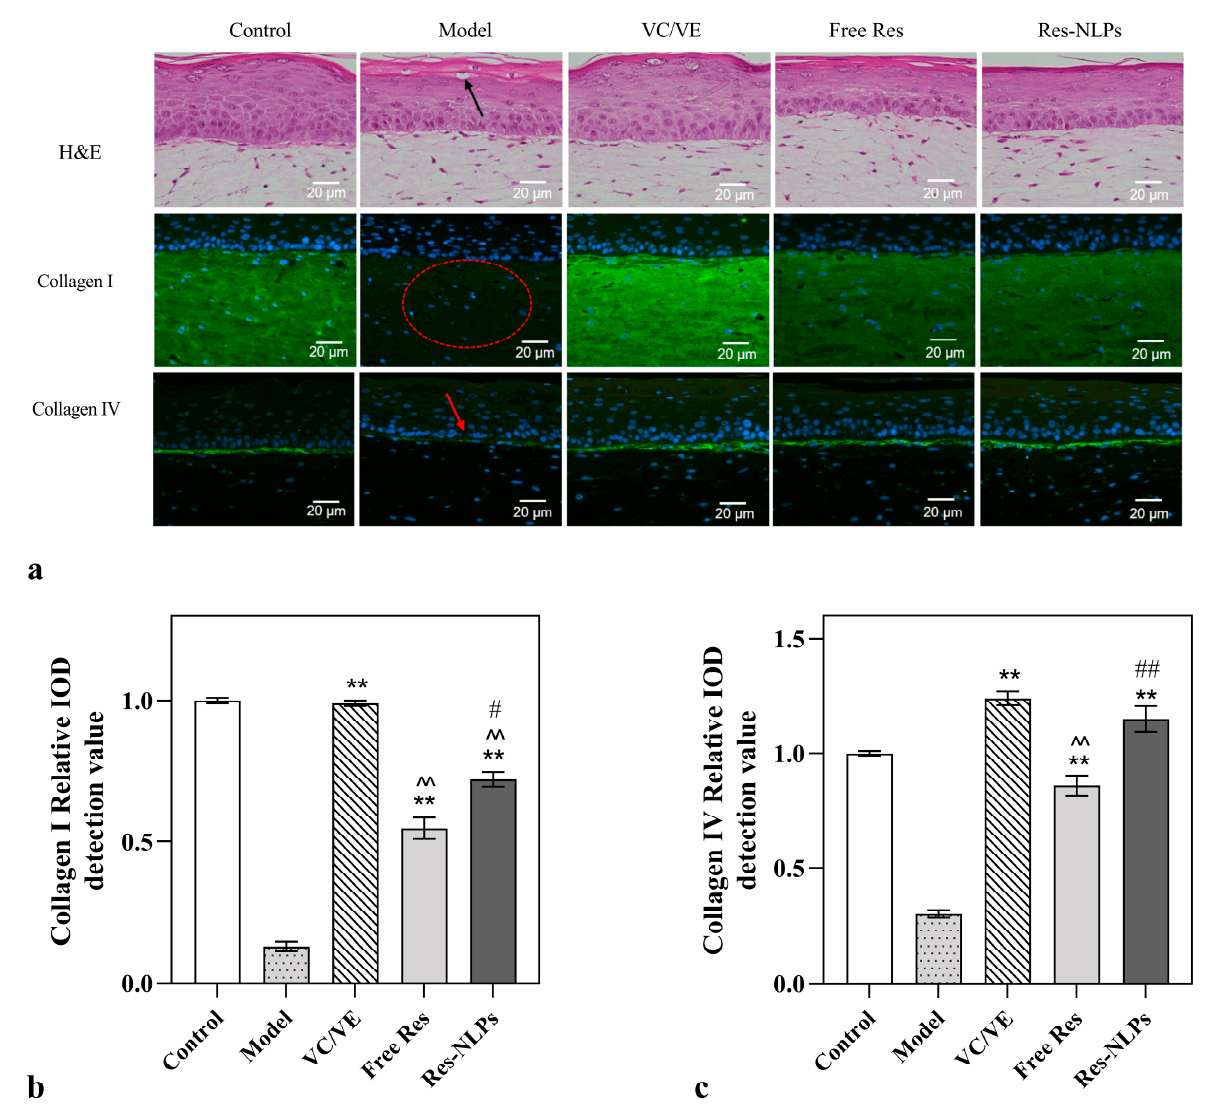
Figure 7. The anti-aging effect of Res studied using the 3D skin models. ( a ) The H&E staining and fluorescent immunization images of collagen I and collagen IV in the 3D skin model treated with 20 µ L 100 µ g/mL VC and 7 µ g/mL VE, 20 µ L 300 µ g/mL free Res or Res-NLPs with the same Res concentration as the free Res, respectively. The relative value of synthesized ( b ) collagen I and ( c ) collagen IV were quantified by immunofluorescence microscopy. Except for the control group (without treatment), the model group, the VC/VE group, the free Res group and the Res-NLPs group were all subjected to continuous irradiation of UVA (35 J/cm 2 ) and UVB (50 mJ/cm 2 ). The 3D skin model treated with irradiation of UVA and UVB served as the model group. Mean ± SD ( n = 3). ** p < 0.01, compared with the model group; ^^ p < 0.01, compared with the VC/VE group; # p < 0.05, ## p < 0.01, compared with the free Res group.